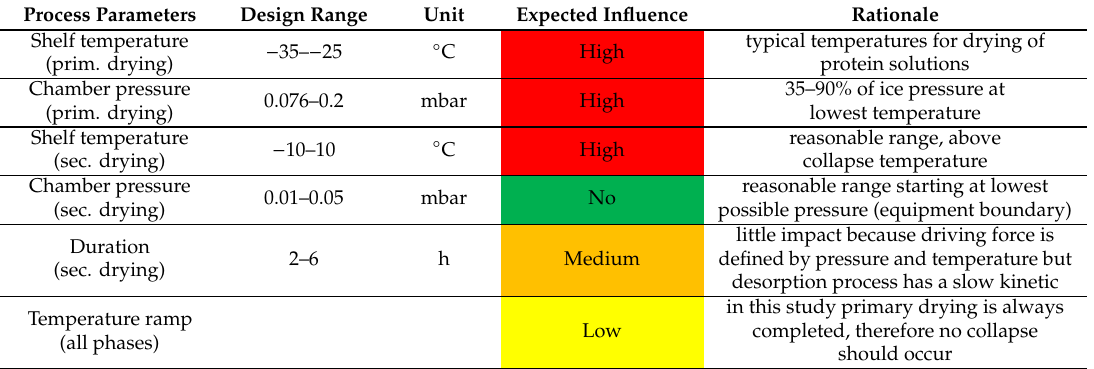
Table 3. Process / model parameters, design range, and their expected influence on the target